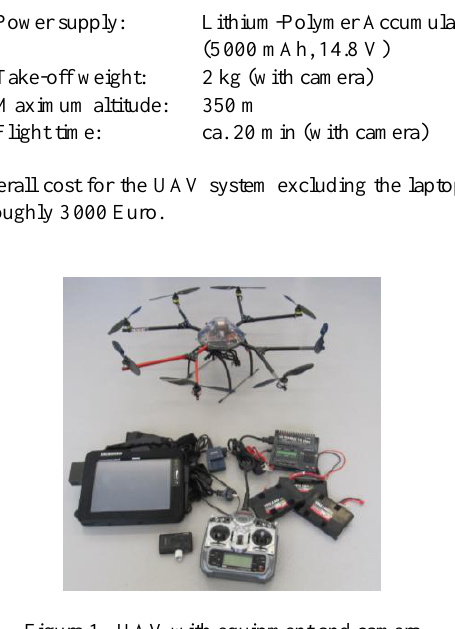
Figure 1. UAV with equipment and